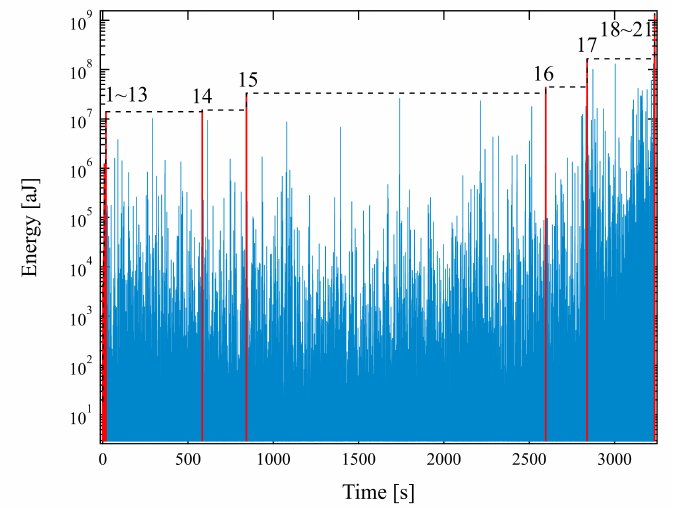
Figure 4. Time sequence of jerk events in coal under uniaxial stress. The spectrum contains 18,968 jerks (blue) and 21 superjerks as record–breaking events. Superjerks are more energetic than any of the previous jerks. Reproduced with permission from [59]. American Physical Society, 2017.